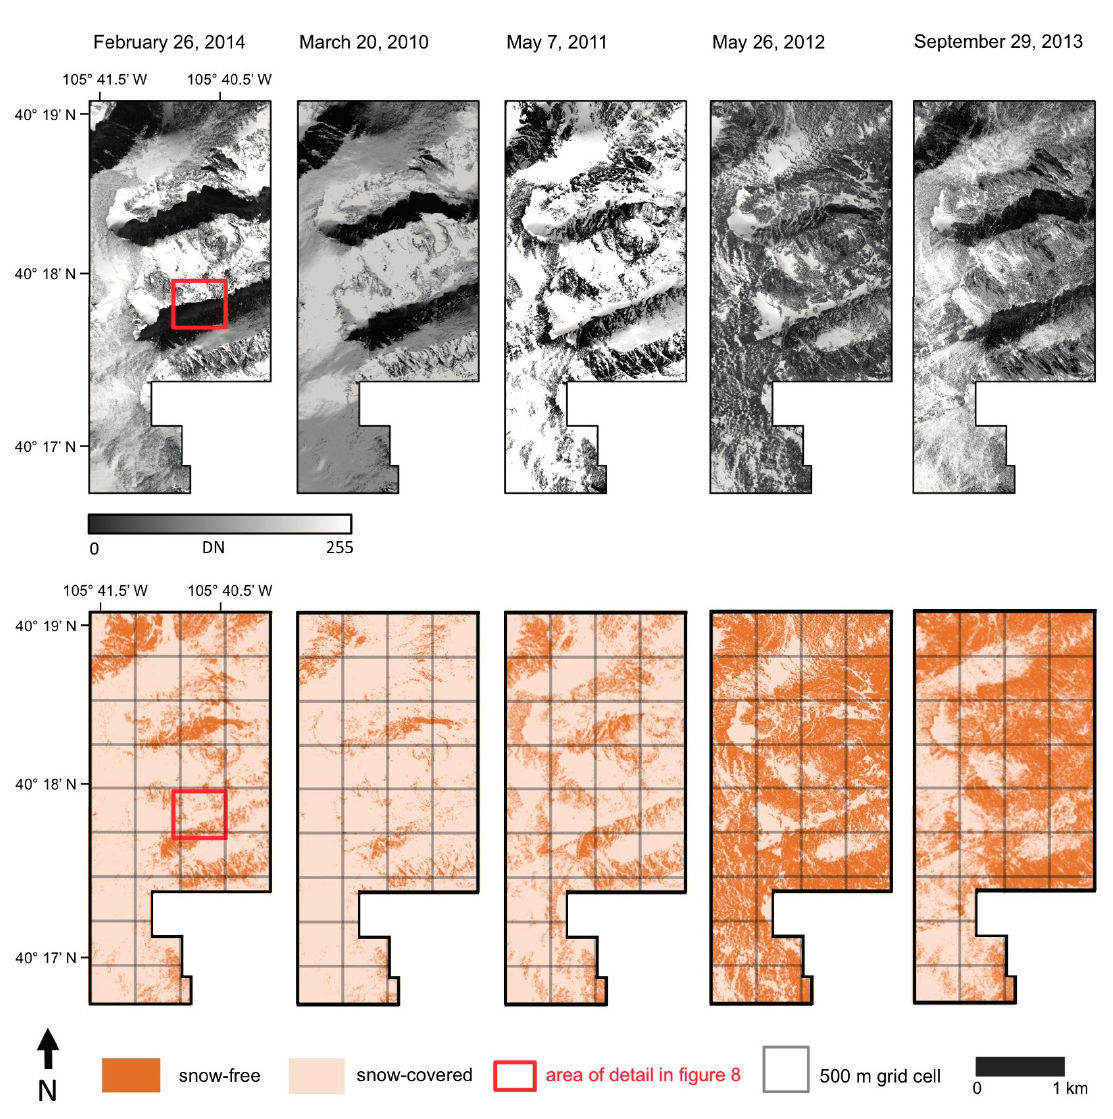
Figure 7. WorldView imagery ( top row ) and high-resolution binary snow-covered area maps ( bottom row ) for the Rocky Mountain NP ISA. Panchromatic band data is displayed for 7 May, while red band data is displayed for the 26 February 2014, 20 March 2010, 26 May 2012, and 29 September 2013